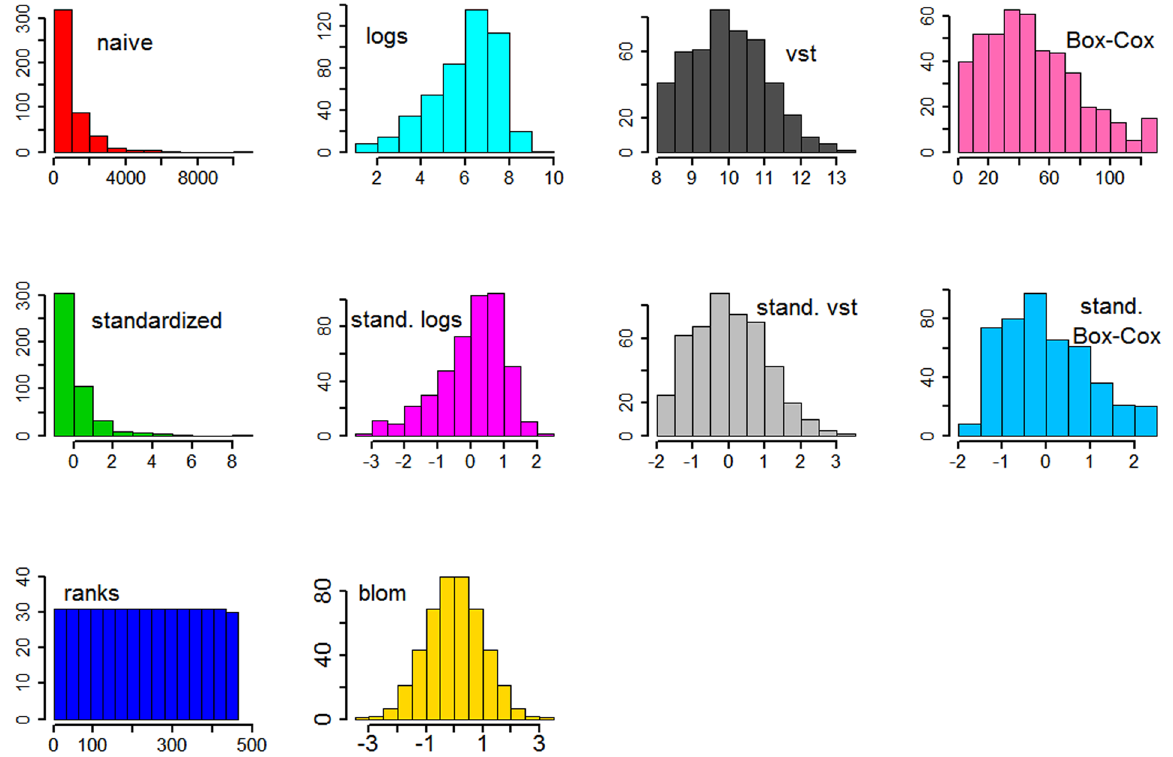
Figure 2. Transformed expression data for gene B3GNT3.